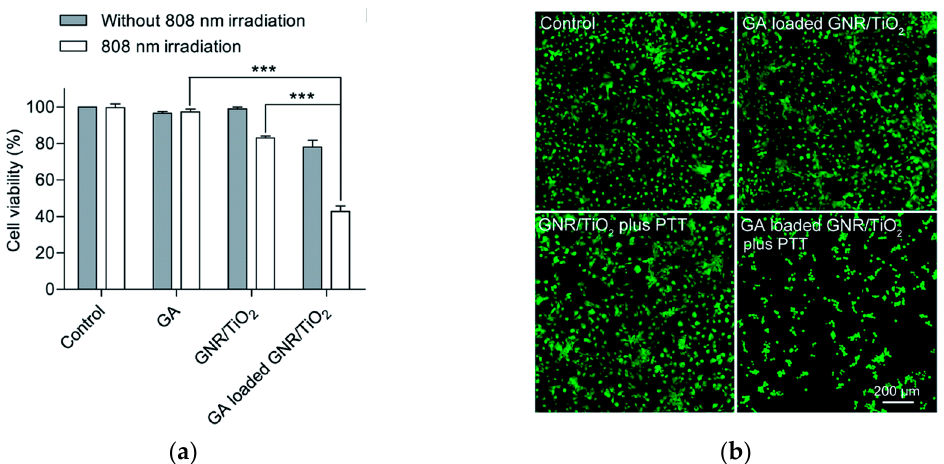
Figure 9. Enhanced cytotoxic e ff ect of GA by using GNR / TiO2 nanostructure-mediated photothermal therapy. U-87 MG cells were incubated with GNR / TiO2 or GA-loaded GNR / TiO2 nanostructures for 24 h, followed by 808 nm NIR irradiation (5.3 W cm − 2 ) for 2 min. After incubation for 24 h, cell viability was determined using an ATP assay ( a ) and calcein AM staining; ( b ) Live cells were stained with green fluorescence by calcein AM. The data shown represent the mean ± S.E.M., *** p < 0.001. Reprinted with permission (after formatting) from [137]. Copyright (2017) The Royal Society of Chemistry.